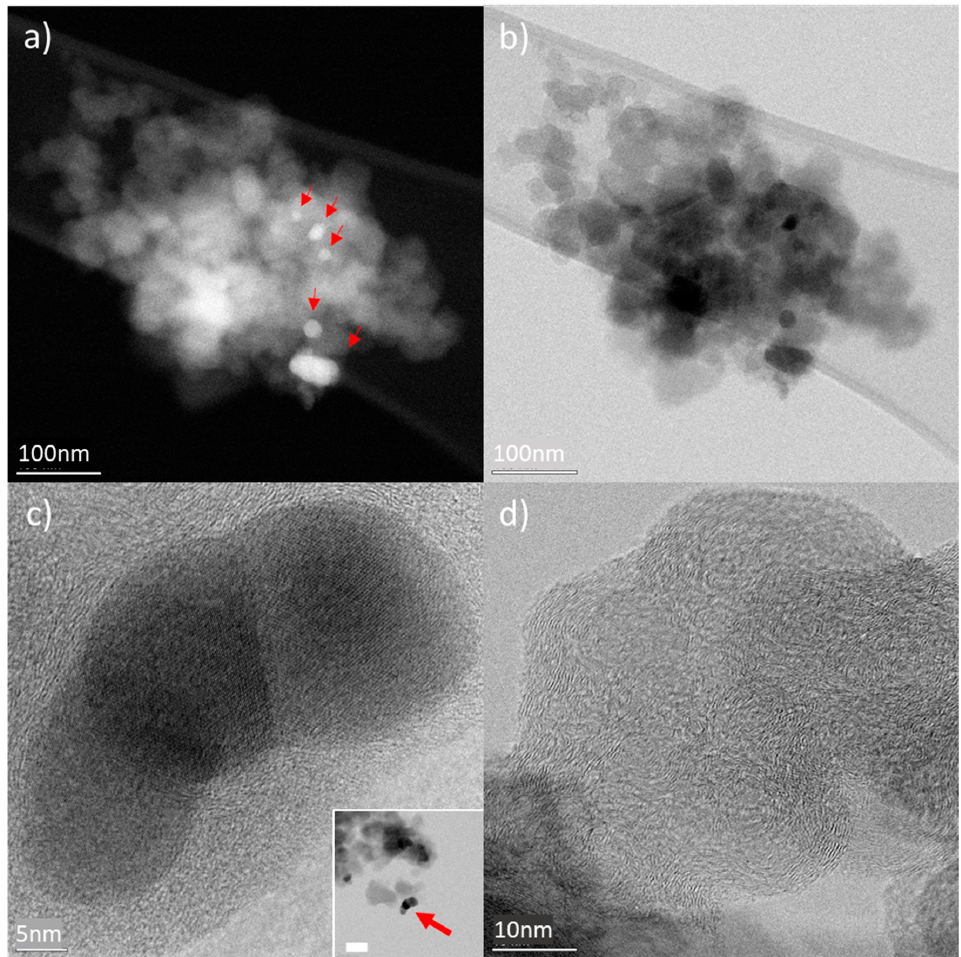
Figure 4. HAADF ( a ) and BF STEM ( b ) images of typical sub-micron clusters of raw char sample crashed powder supported by amorphous carbon film. Z contract in HAADF STEM images show the presence of inorganic nanocrystals (indicated by the red arrows). HR-BF STEM images of nanoparticles showing good crystallinity ( a ) as well as the degree of graphitisation of the char material ( c ) . Inset in ( c ) shows an overview of the flake containing the nanoparticles (bar corresponds to 50 nm). The sample with optimal electrocatalytic performance corresponding to 30-s deposition (sample CHecCo30s ) was investigated by STEM before and after electrocatalysis. The sample